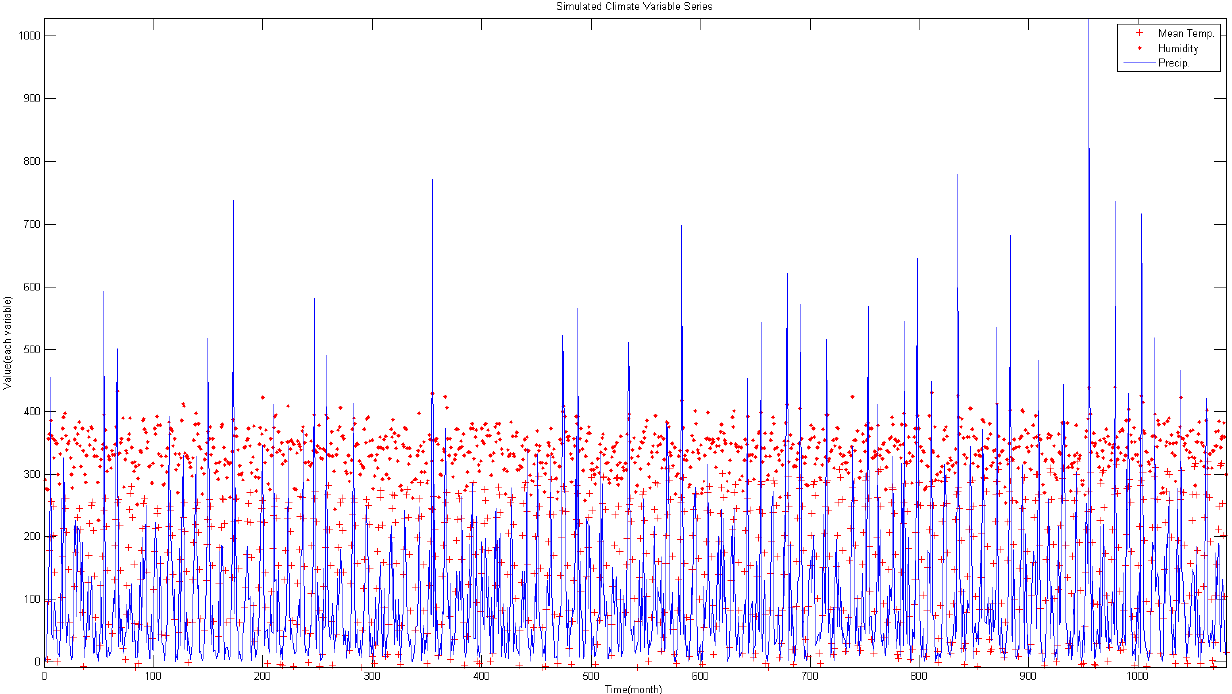
Figure 7. Simulated climate variable (2011–2100).